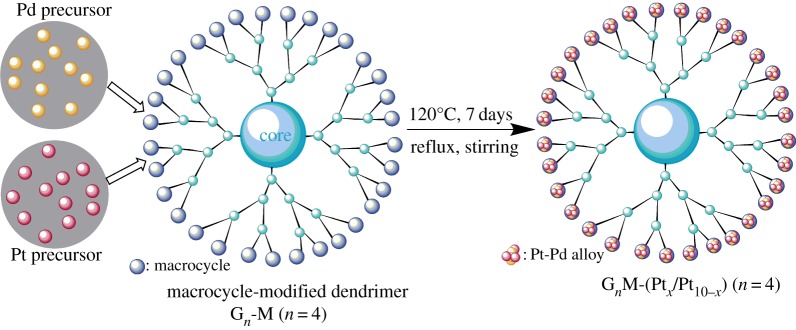
The synthesis route of GnM-(Ptx/Pd10−x) (n = 2, 3, 4, 5).